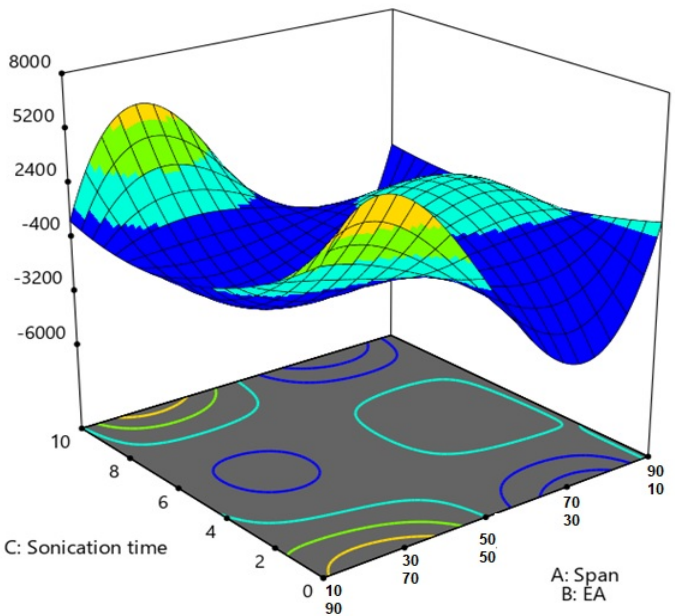
Figure 2. Effect of the binary mixture components (I) and the sonication time (II) at the mid-values of the other variables; Three-dimensional mixture − process plot (III) for the particle size of luliconazole spanlastics.